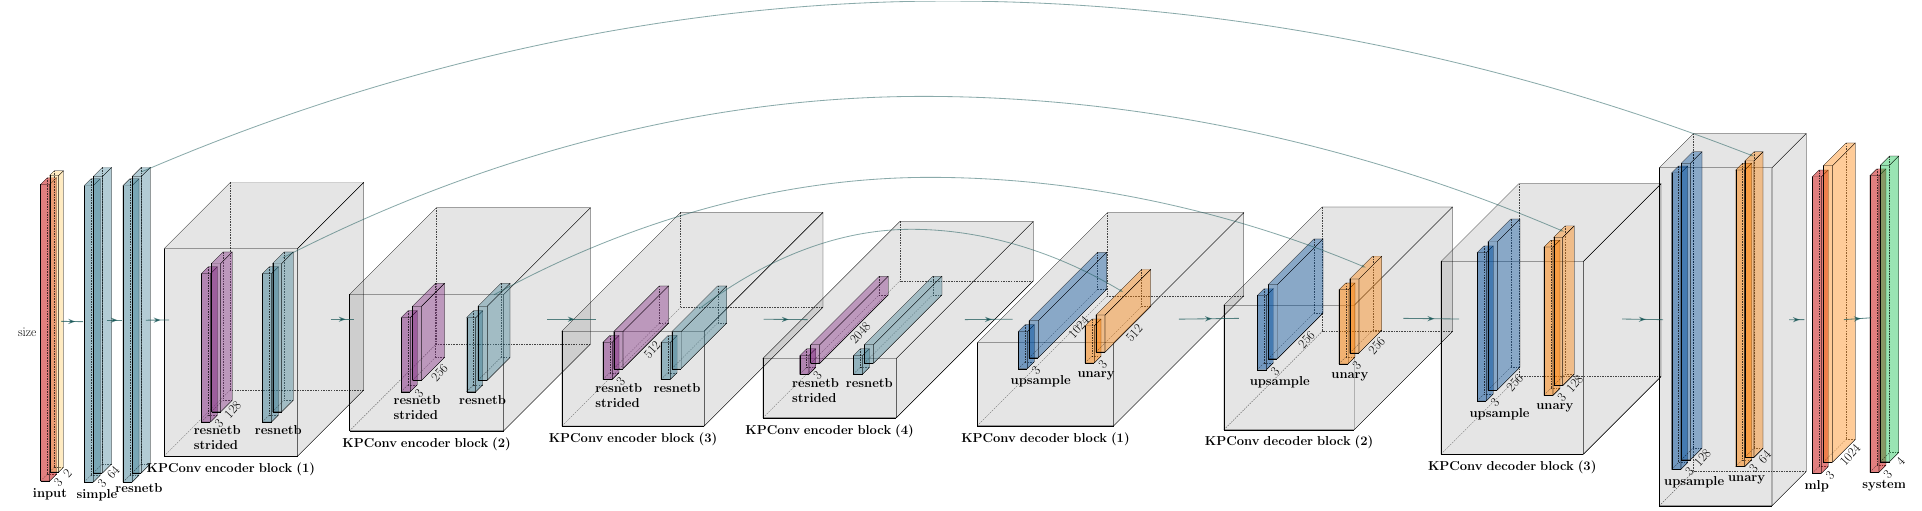
Figure A7. Discussed architecture used by Soilán et al. [26] for their TL approach. The most notable differences are the reduced encoder block, the initial feature count of 64 and the reduced class output of